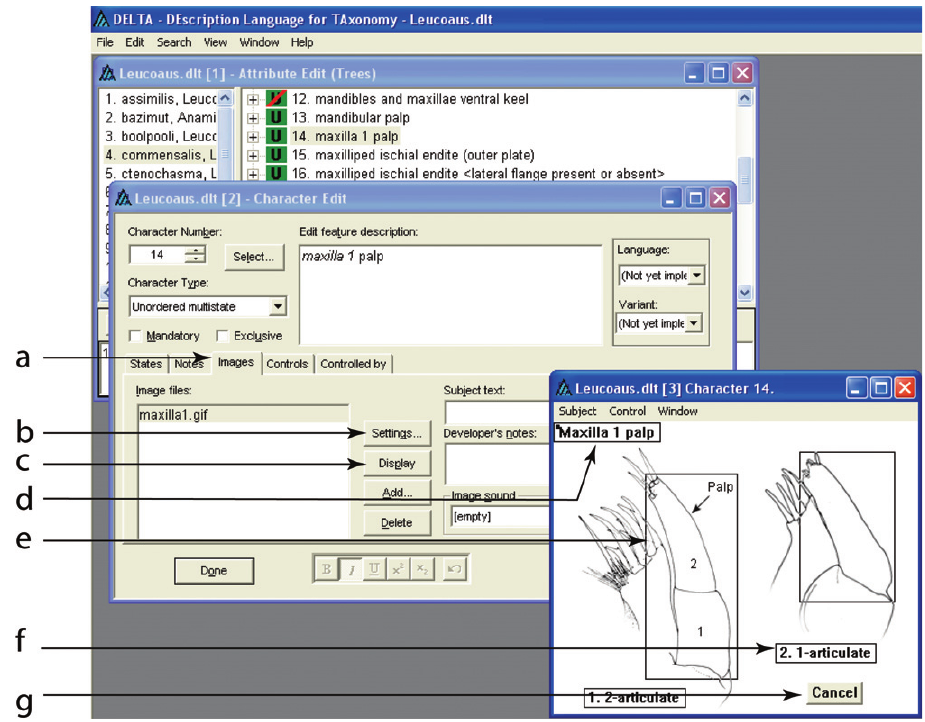
Figure 17a–g. Character state images. a the Images tab in the Character editor b Settings allow the selec- tion of the path to the image directory and font details for the overlays c Display shows the selected image fi le in a window with the character and overlay boxes d feature text of the character e Hotspot selection box f character state overlay box g Cancel box. Th ese overlays are used in